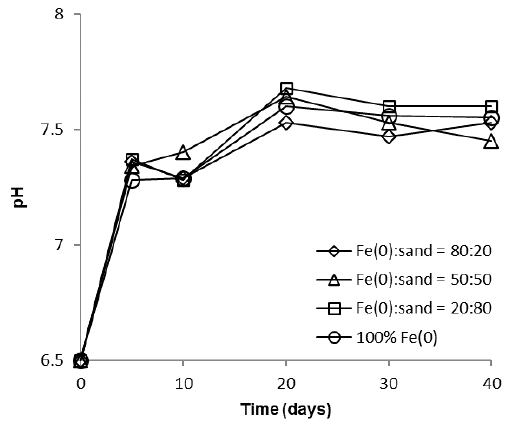
Figure 6. Evolution of pH in batch experiments at low Cr VI initial concentration.